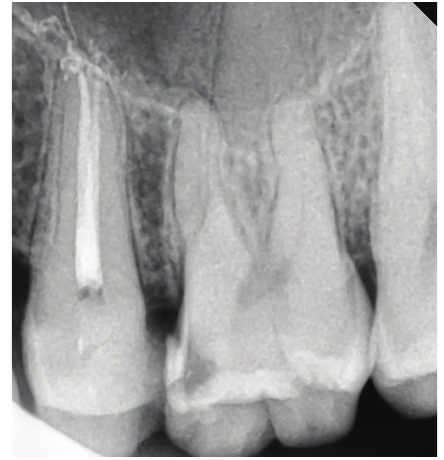
Figure 4: Two roots with two separate canals.